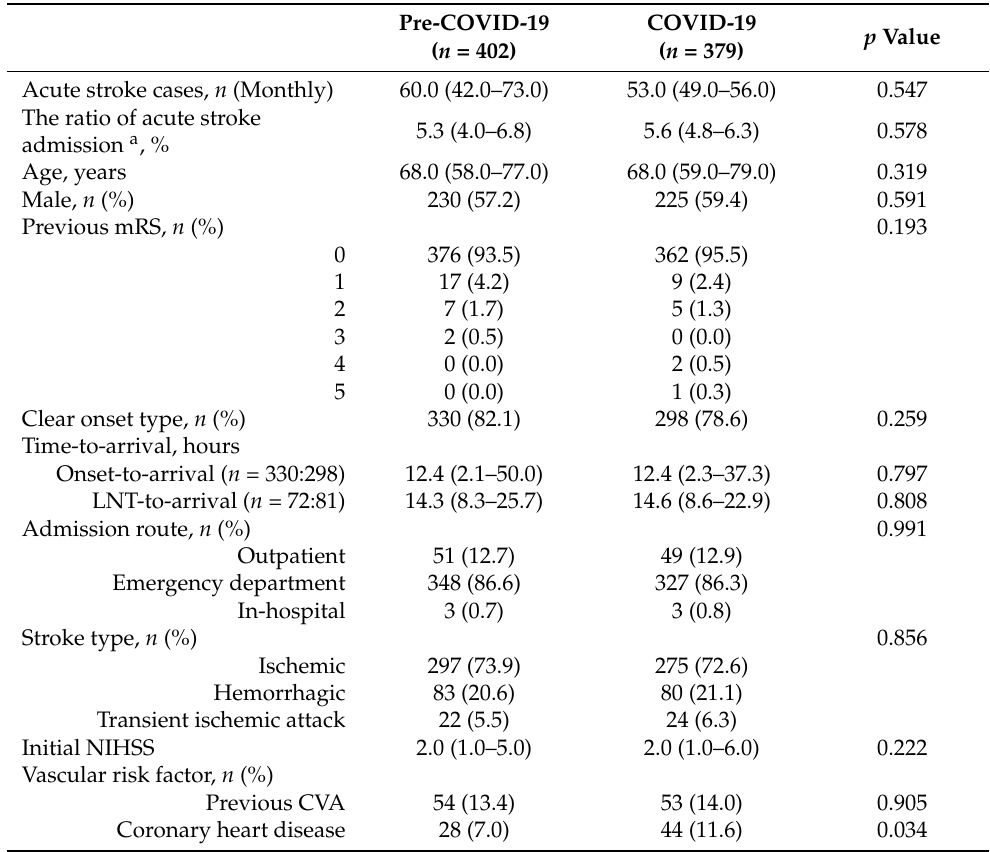
Table 1. Demographic and disease-related characteristics of patients with stroke during the COVID-19 and pre-COVID-19